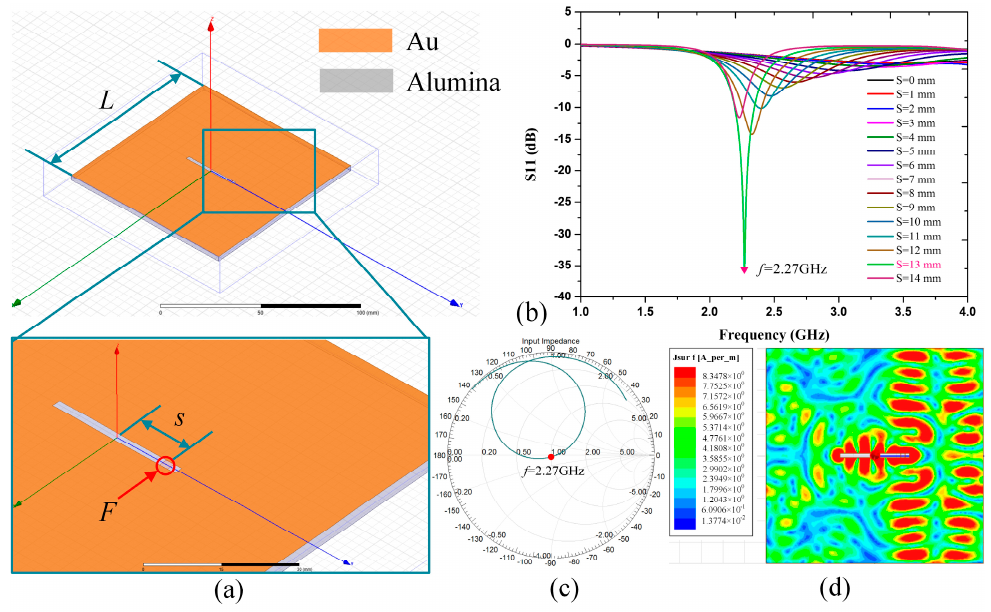
Figure 2. HFSS design of the sensor. ( a ) 3D view in HFSS. ( b ) The simulated frequency versus S(1,1) with the feeding point’s location S = 0, 1, 2,…14 mm, respectively. ( c ) The Smith Chart of impedance with reference to 50 Ω feeding port and ( d ) surface current distribution when the sensor is fed with S = 13 mm at resonant frequency of 2.27 GHz.